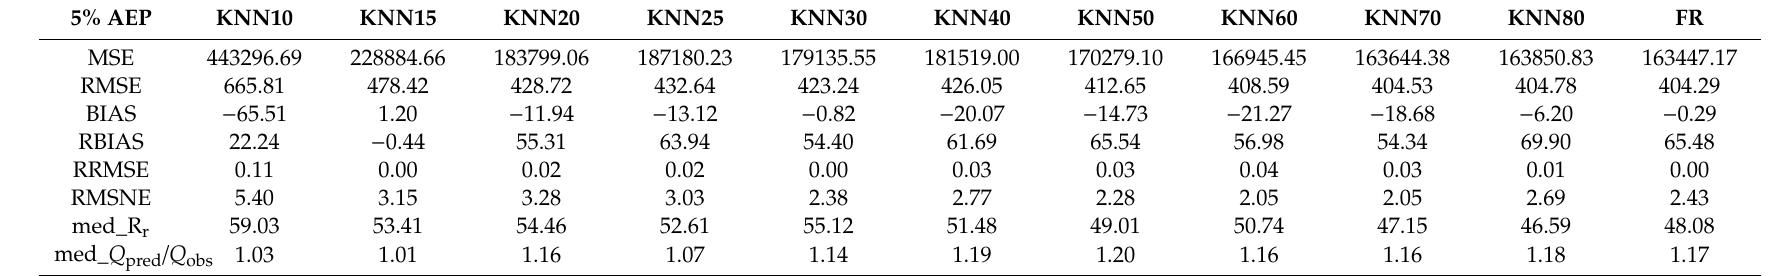
Table 4. Statistical evaluation for fixed region (FR) and region of influence (ROI) for 5% annual exceedance probability (AEP)